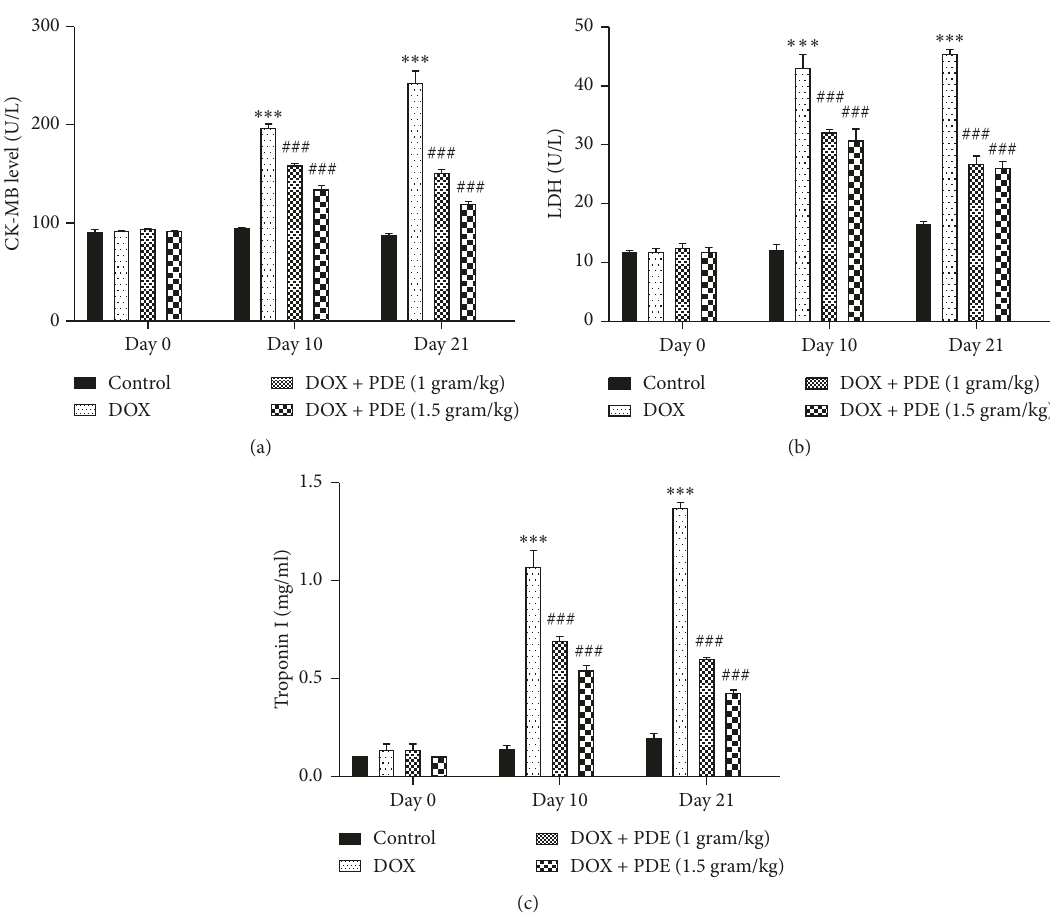
Figure 1: Effects of PDE on serum (a) CK-MB, (b) LDH, and (c) troponin levels in DOX-induced changes in rats. The values are mean ± SEM ( n � 6). Statistical analysis was done through two-way analysis of variance (ANOVA) followed by Bonferroni post hoc test. For determination of p values, DOX is compared with the control group, and treatment groups were compared with the DOX group. The results are considered significant if p < 0 . 05. ∗∗∗ p < 0 . 001 vs. control and ### p < 0 . 001 vs.